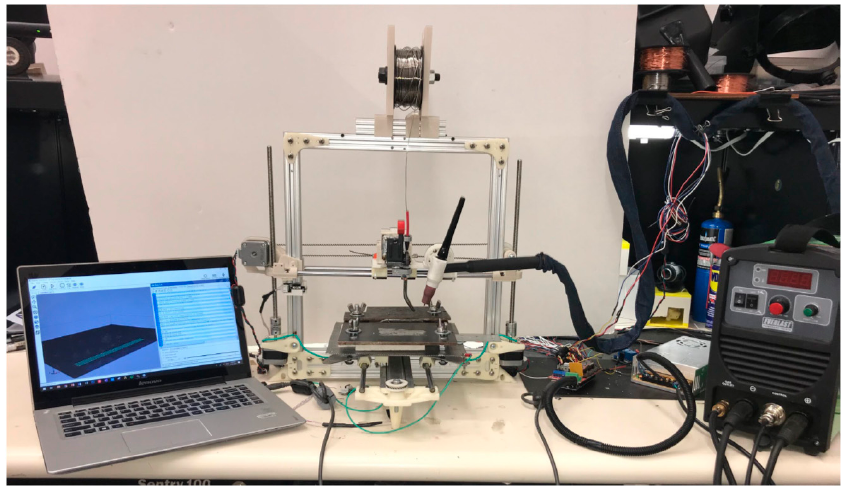
Figure 2. Assembly of the WAAM system components.